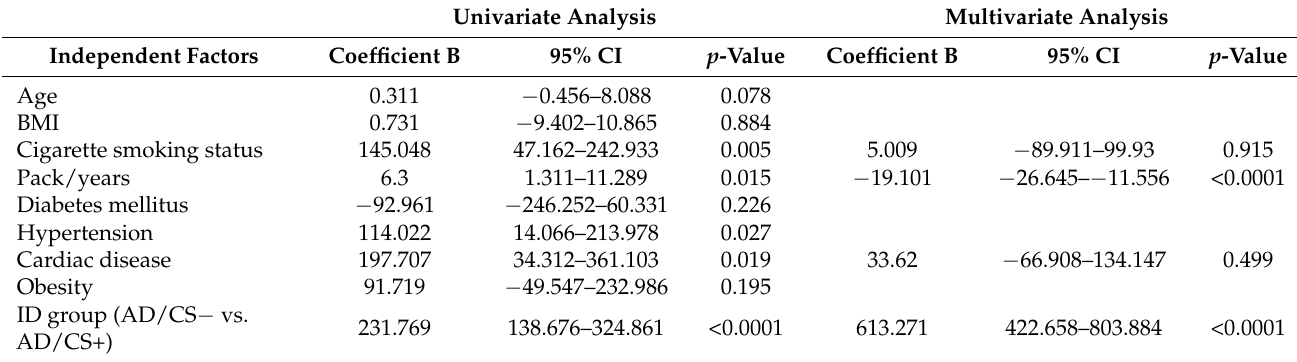
Table 4. Univariate and multivariate linear regression analysis of factors associated with miR-133a-3p levels in AD patients. Univariate Analysis Multivariate Analysis